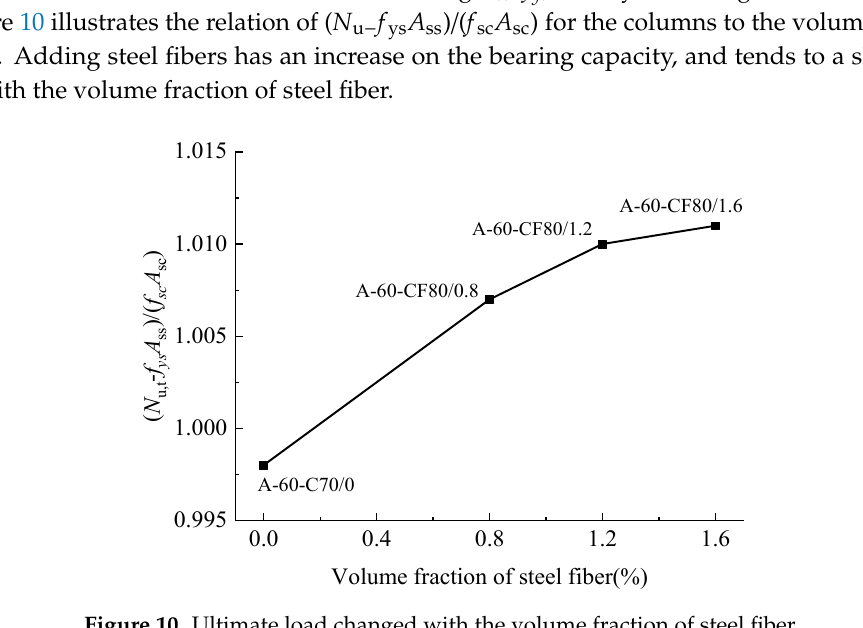
Figure 10. Ultimate load changed with the volume fraction of steel fiber.